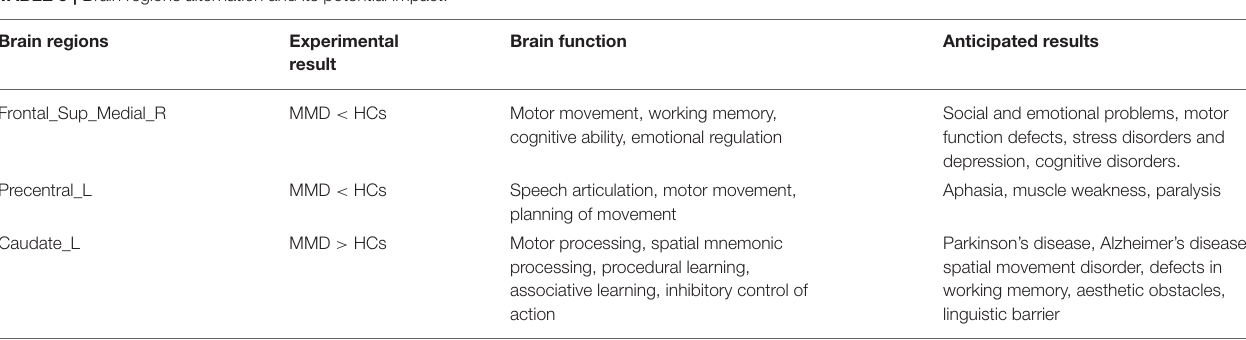
TABLE 5 | Brain regions alternation and its potential